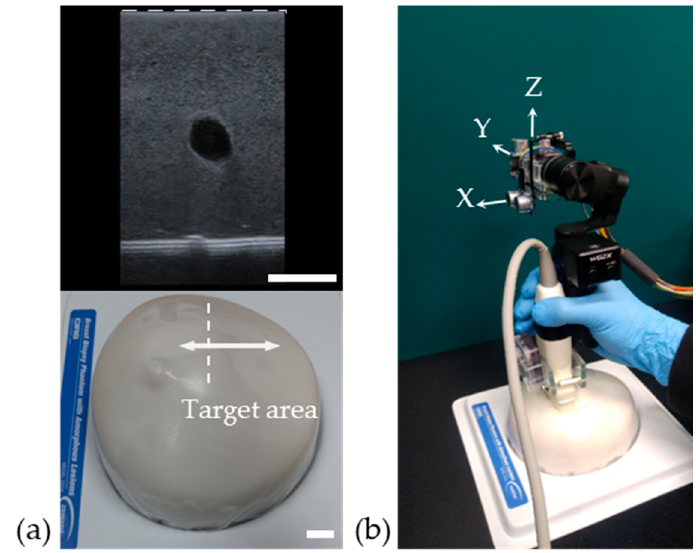
Figure 5. ( a ) Breast biopsy phantom containing a cystic mass, and the corresponding ultrasound image. The dashed lines of the upper and lower figures indicate the same spatial ranges. ( b ) Image of the target area (cystic mass in the breast phantom) using the ultrasound probe that contains the low-cost devices for position data acquired with a bare hand. All scale bars are 15 mm.